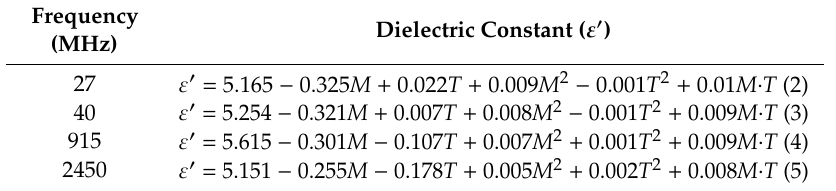
Table 3. Regression equations for the dielectric constants of the pecan kernels as functions of the